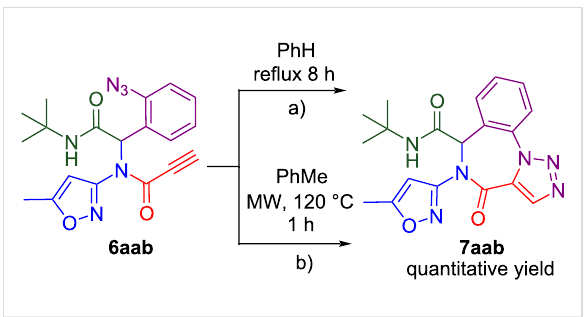
Ugi products and their successors. Therefore, namely com- pound 6aaa was chosen as a model substrate for the conditions